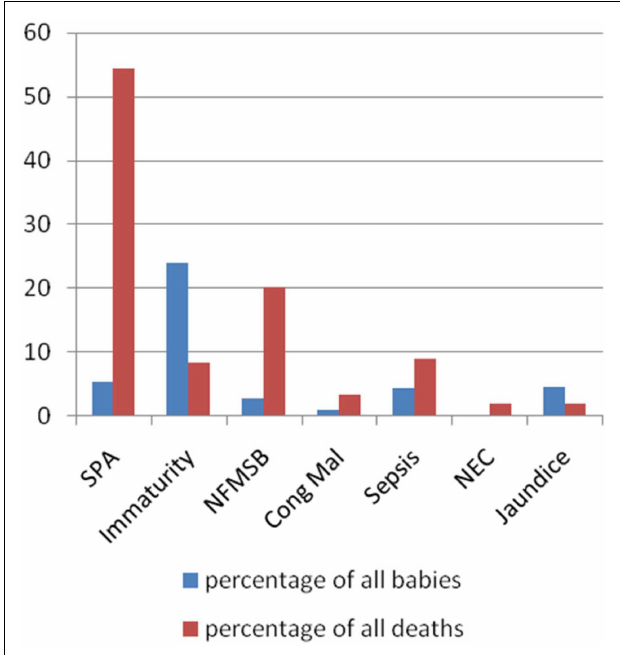
FIGURE 1 |Wigglesworth classification of perinatal mortality . SPA, severe perinatal asphyxia; NFMSB, normally formed macerated stillbirth; Cong Mal, congenital malformations; NEC, necrotizing